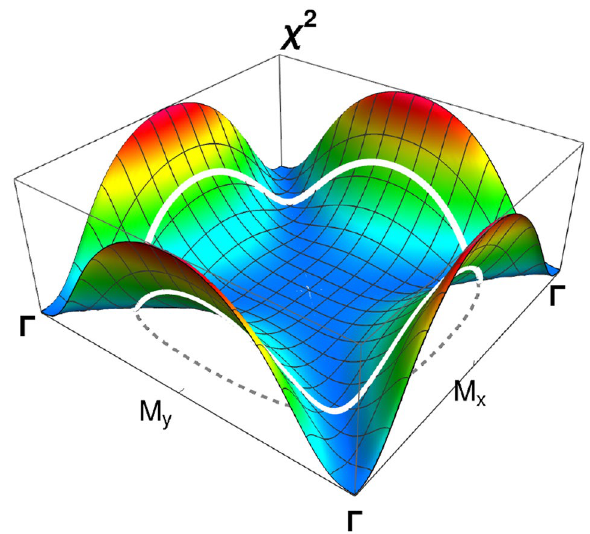
Fig. 2 The hybridization probability 𝜒 2 M points correspond to hot spots, while the navigation channels in the deep blue sea along the diagonals between the Γ points corre‑ spond to cold spots in agreement with both Refs. [2, 3]. Fermi con‑ tour (dotted line) is projected on the 𝜒 2